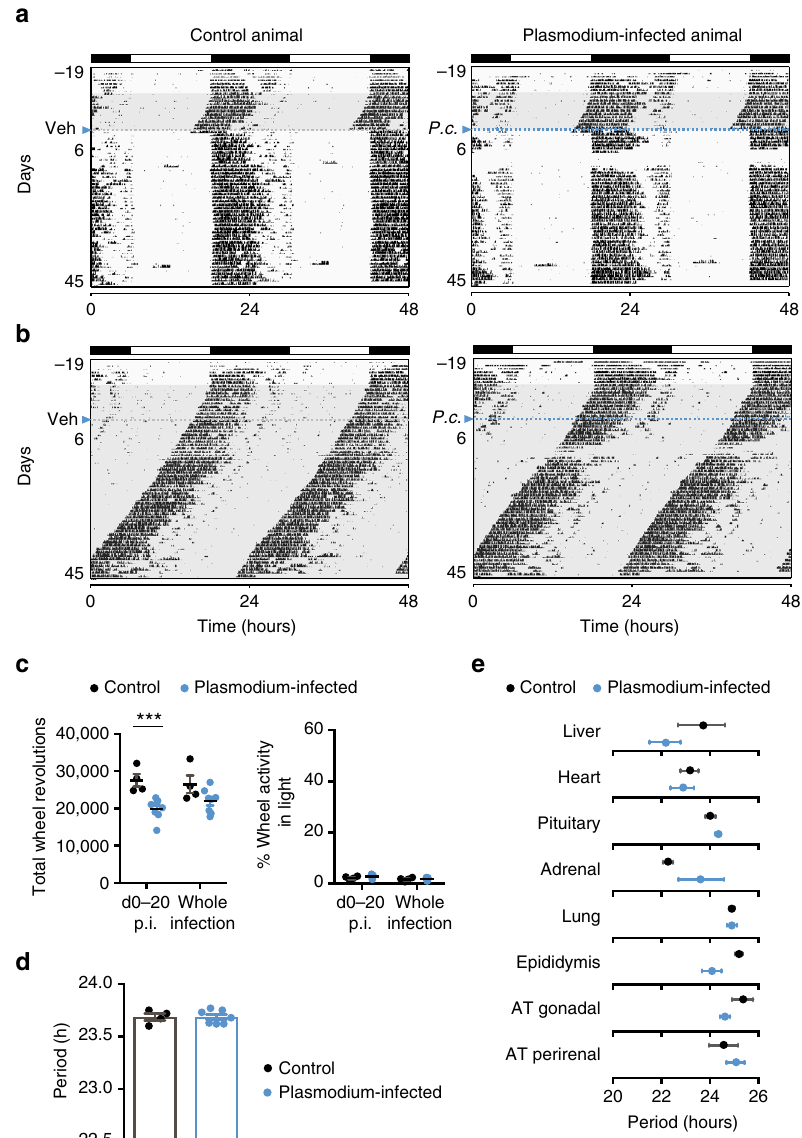
Fig. 5 Plasmodium infection does not change host ’ s circadian period. a Representative actograms of daily wheel-running activity of control and Plasmodium-infected mice (LD). All running-wheel experiments involve seven days on LD12:12 followed by 10 days in DD to con fi rm that all animals have a normal circadian rhythm, after which animals are either infected or injected with vehicle. Horizontal black and white bars at the top of each actogram represent lights off and on for the initial acclimatization period, respectively. b Representative actograms of daily wheel-running activity of control and Plasmodium-infected mice in constant darkness (DD). c Total daily and relative rest-period activity levels of control ( n = 4) and infected ( n = 8) mice considering the whole infection time and a 20-days post-infection interval. d Period of running-wheel activity of control ( n = 4) and infected ( n = 8) mice. Error bars show mean ± s.e.m.; * p < 0.05, ** p < 0.01, *** p < 0.001 tested with Mann – Whitney test in panels c and d . e PER2::LUC period plot of various tissues harvested from control (black) and Plasmodium-infected (blue) mice. No signi fi cance was found, p > 0.05, FDR method Benjamini –